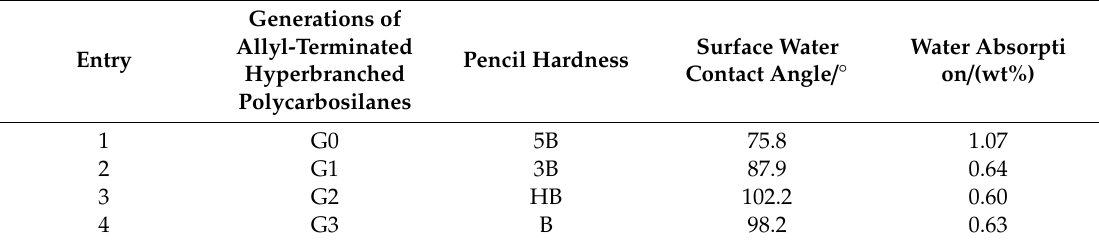
Table 6. The influence of generations of allyl-terminated hyperbranched polycarbosilanes. Generations of Allyl- Pencil Entry